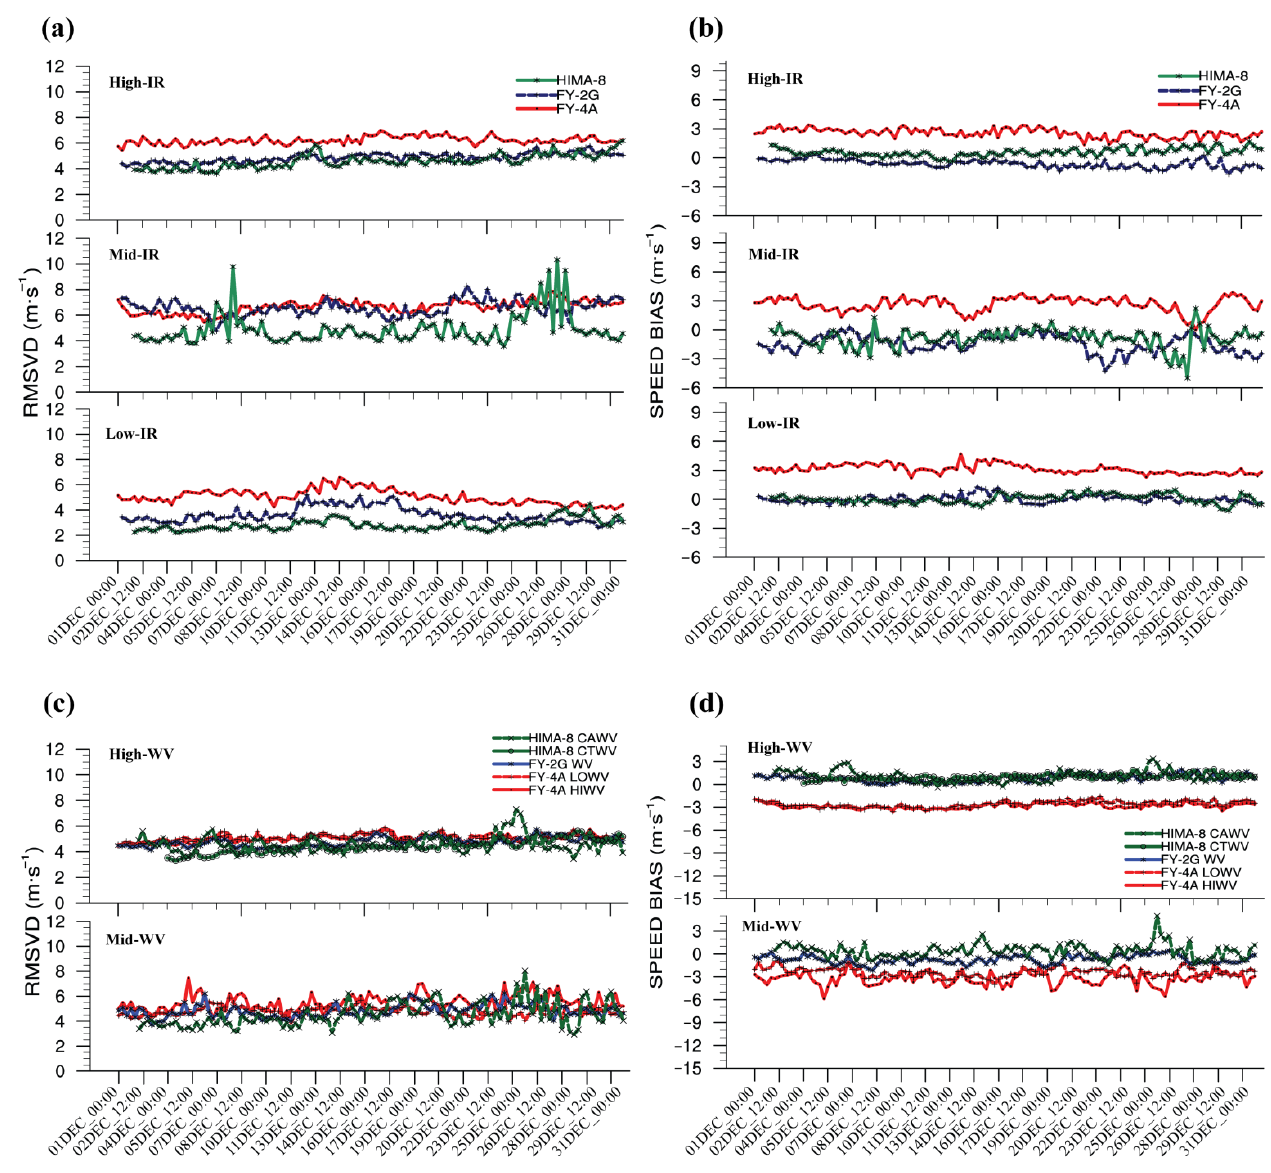
Figure 7. The time series of IR AMVs at high, mid, and low-levels averaged for ( a ) the RMSVD, ( b ) the BIAS while WV AMVs at high-, mid-levels averaged for ( c ) the RMSVD, and ( d ) the BIAS at QI 85% over the research domain in December 2018 by taking measurements four times a day (00:00, 06:00, 12:00 and 18:00 UTC) when validated with NCEP FNL wind analysis.